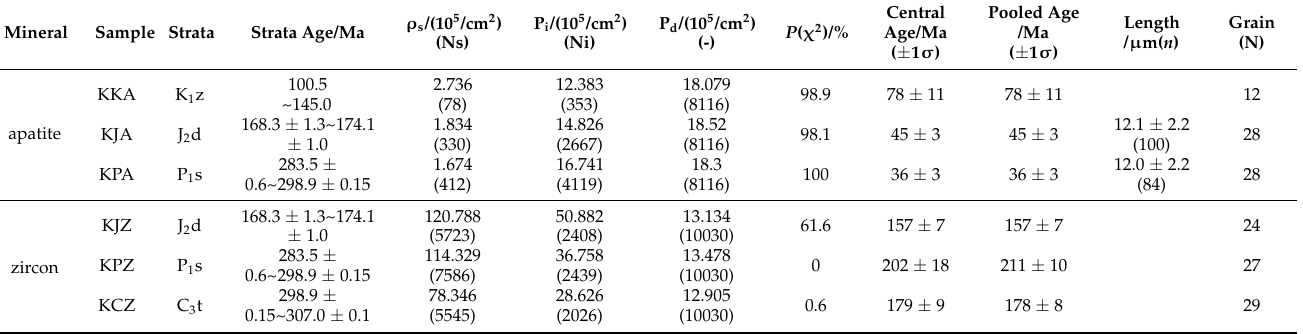
Table 4. The test results of fission track ages and lengths for the samples of Datong Coal-bearing